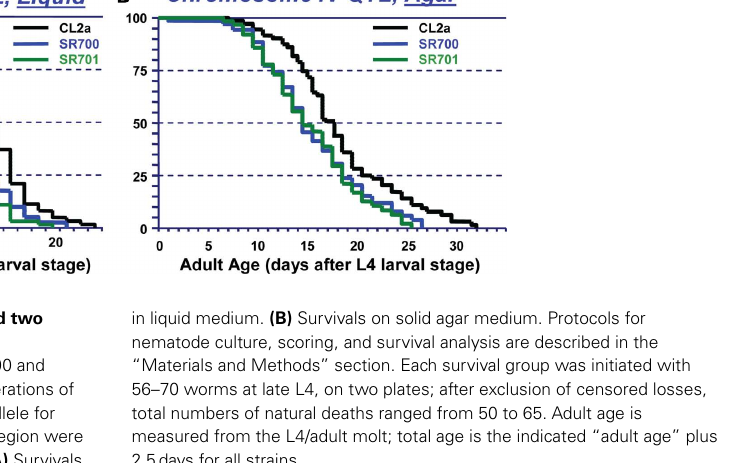
FIGURE 2 | Survivals of C. elegans wild-type strain CL2a, and two congenic lines derived from CL2a by introgression of the chromosome IV stP13–stP35 region from Bergerac-BO. SR700 and SR701 are independent congenic lineages generated by 20 generations of backcrossing, with marker-based selection of the Bergerac-BO allele for stP13, stP44, and stP35. Homozygotes for the introduced lsq4 region were ascertained, expanded, and used to measure survival at 20˚C. (A) Survivals